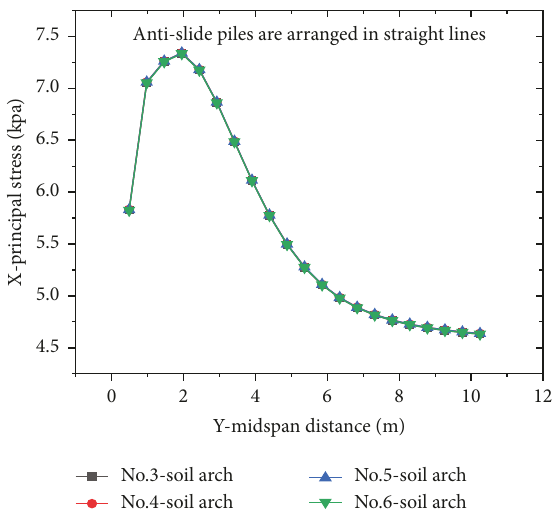
Figure 8: X -directional principal stress curve at midspan of soil arch.